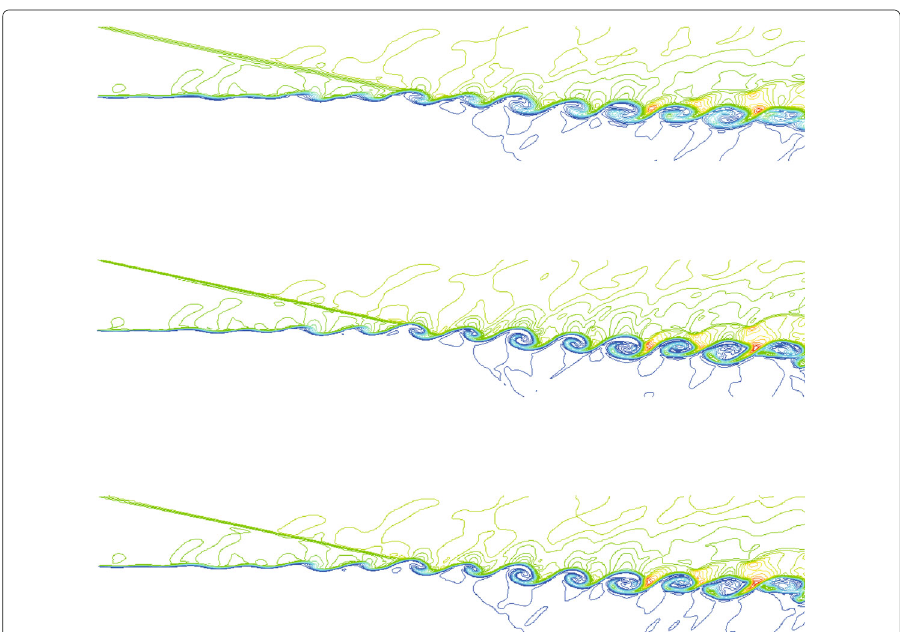
Fig. 9 Density contours of two-dimensional viscous shock-mixing layer interaction problem. T = 120. Top: coarse uniform grids (400 × 80). Middle: fine uniform grids (800 × 160). Bottom: adapted grids based on coarse grid